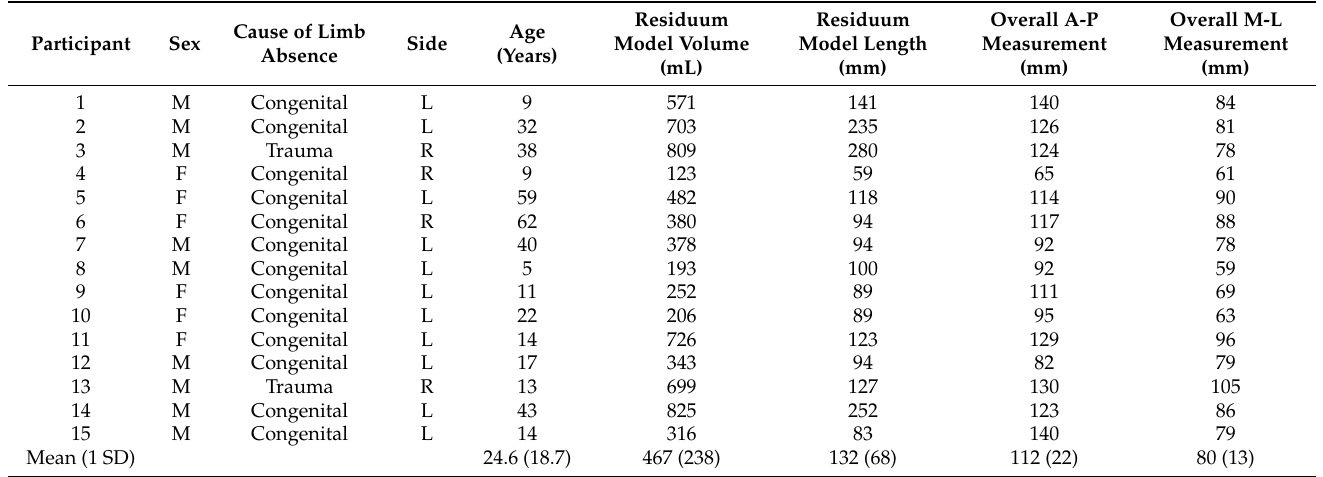
Table 1. Participant Characteristics. Participants were listed chronologically based on the date of shape capture appointment.